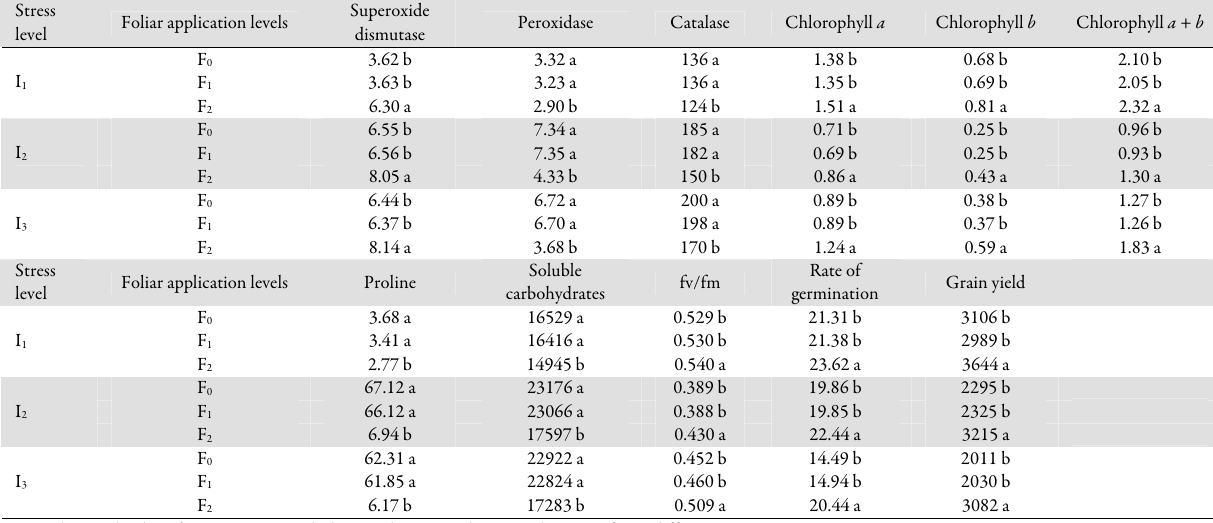
Table 4. Interaction effect of water stress and foliar application in yield physiological traits and seed vigor of two soybean cultivars Stress